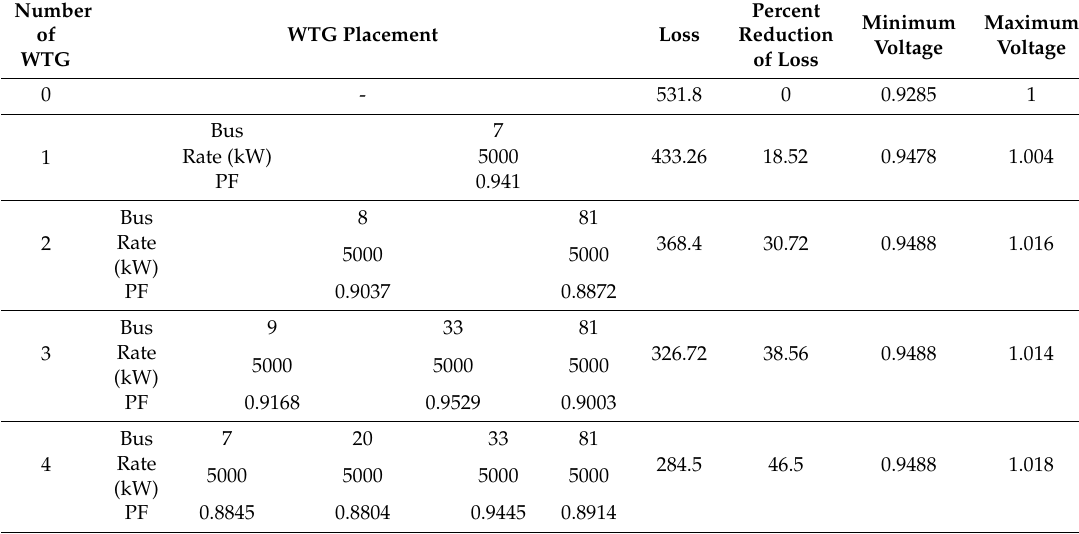
Table 2. Results of optimal site selection of turbines without considering constraints (multi-objective).